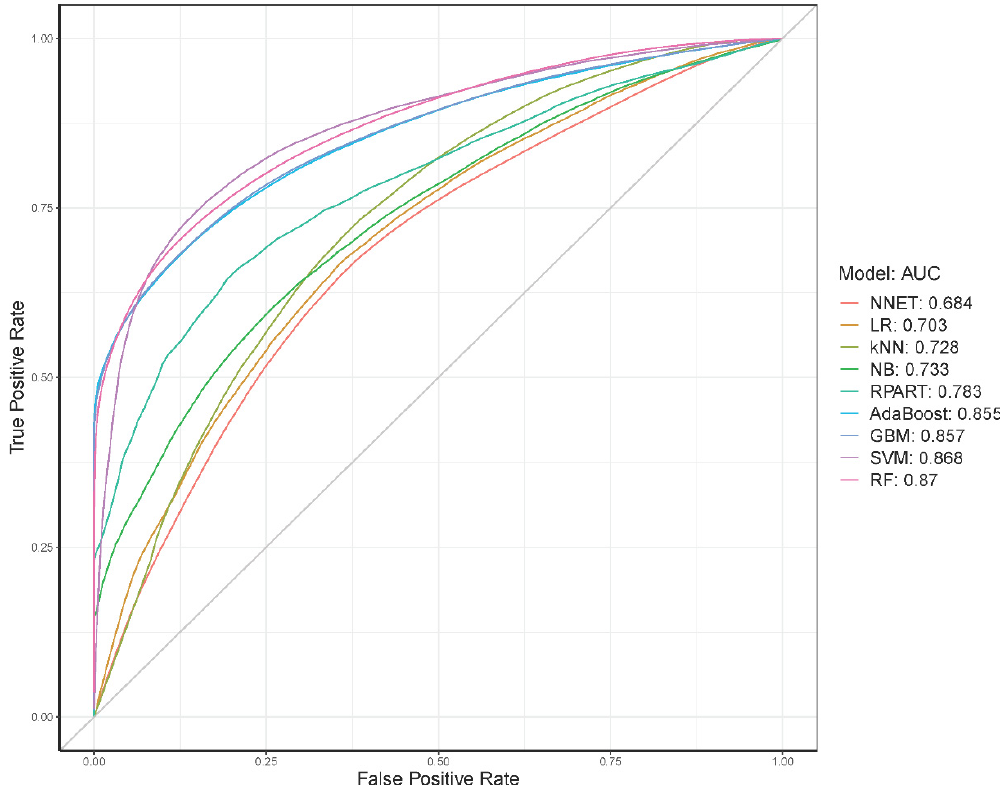
Figure 2. Receiver operating characteristic (ROC) curves for the nine machine learning (ML) models in Set 1 in predicting postpartum depression. Ten-fold cross-validation was used to build and evaluate the prediction models. Different colors represent the top four machine learning classifiers used in this study. The false positive rate is equal to (1–specificity). The gray line is the reference corresponding to the performance of a classifier that completely and randomly classifies the condition. Table 3. Average metrics of nine ML models across all independent datasets.